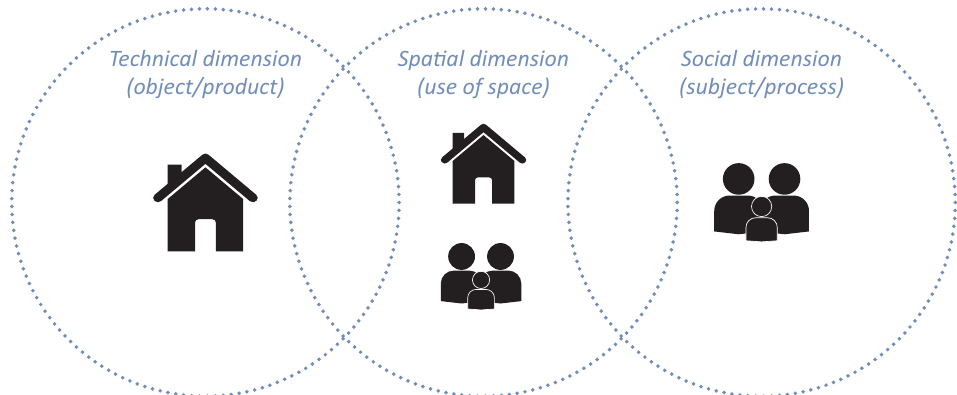
Figure 1. Framework used to identify the design principles of Existenzminimum. Source: author.